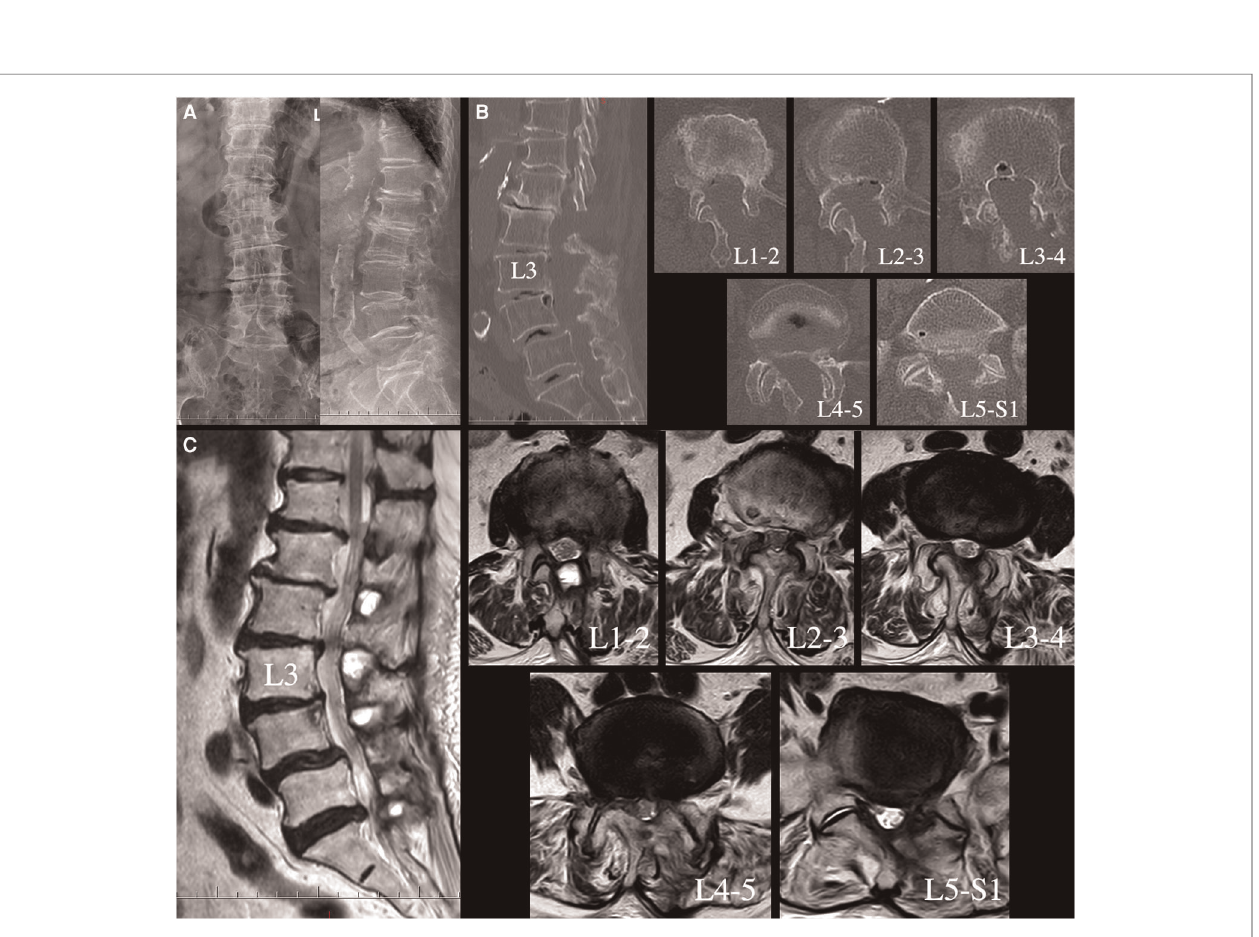
FIGURE 5 | The lumbar X-ray radiograph of 1-year follow-up demonstrating all surgical segments remained stable ( A ). Lumbar CT of 1-year follow-up showing the bony structure changes of surgical segments ( B ). Sagittal and axial T2-weighted lumbar MRI revealing satisfactory decompression of lumbar canal from L1-2 to L5-S1 ( C ).